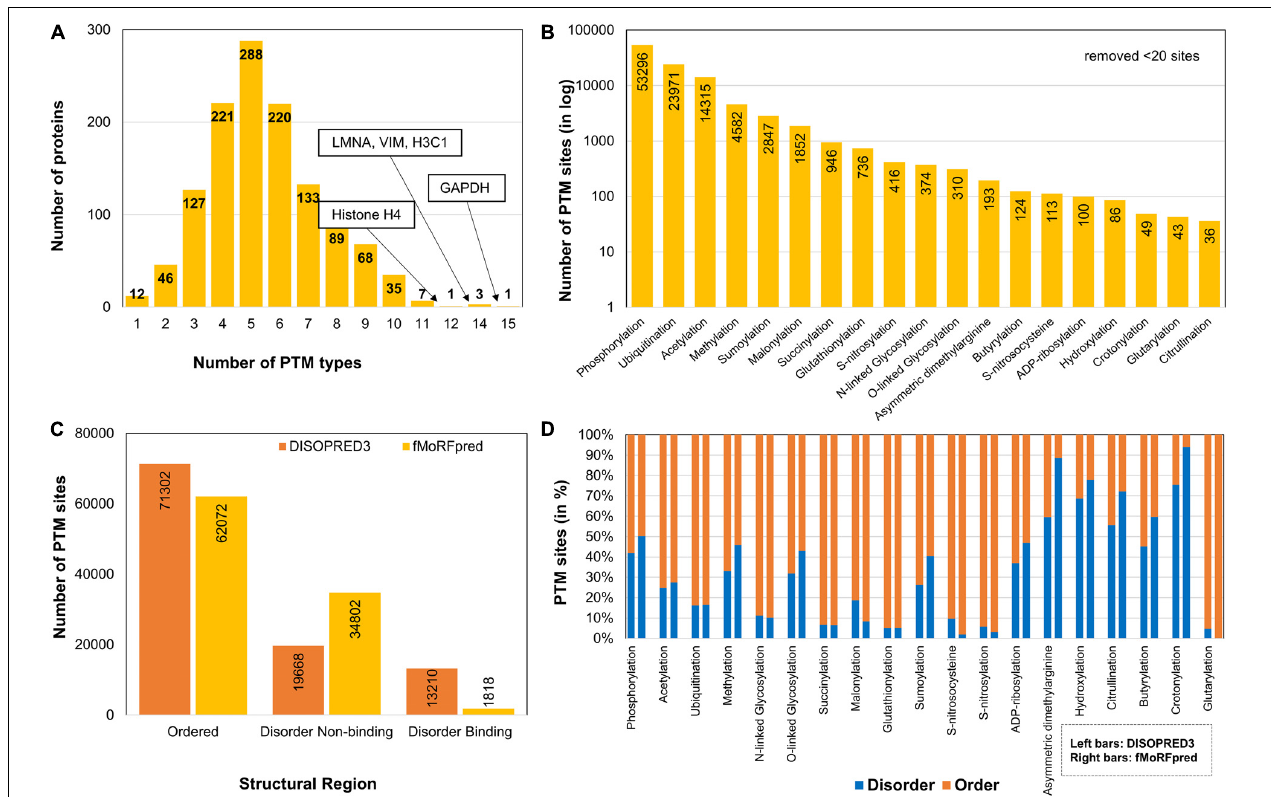
FIGURE 2 | Dataset description after parsing and integrating for different PTM types in sirtuin interactors. (A) Frequency bar chart depicting the number of proteins that contain one or more PTM types. Most histones and GAPDH contained a higher number of PTM types than other proteins. (B) Distribution of sites for each PTM type shows phosphorylation, ubiquitination, and acetylation to be most predominant ones in sirtuin interactors. (C) Post-translational modification sites found in structural regions as predicted by DISOPRED3 and fMoRFpred. It shows most PTM sites map to ordered regions. (D) The division of each PTM in the type of structural